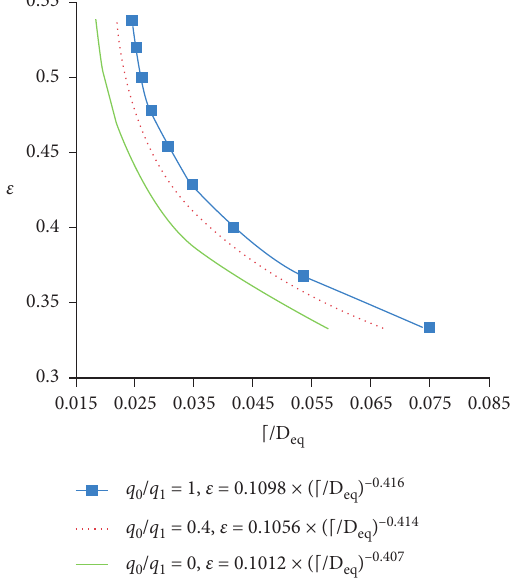
Figure 12: Interrelation curve between the dimensionless dis- placement of the pile head and the embedded ratio of the pile with different values of q 0/ q 1 .